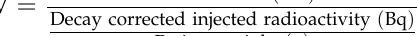
(cid:3145)(cid:3163)(cid:3159)(cid:3177)(cid:3179)(cid:3176)(cid:3163)(cid:3162) (cid:3176)(cid:3159)(cid:3162)(cid:3167)(cid:3173)(cid:3159)(cid:3161)(cid:3178)(cid:3167)(cid:3180)(cid:3167)(cid:3178)(cid:3183) (cid:4666)(cid:3134)(cid:3175)(cid:4667) (cid:3154)(cid:3173)(cid:3182)(cid:3163)(cid:3170) (cid:3180)(cid:3173)(cid:3170)(cid:3179)(cid:3171)(cid:3163) (cid:4666)(cid:3171)(cid:3144)(cid:4667) Measured radioactivity ( Bq ) (cid:3136)(cid:3163)(cid:3161)(cid:3159)(cid:3183) (cid:3161)(cid:3173)(cid:3176)(cid:3176)(cid:3163)(cid:3161)(cid:3178)(cid:3163)(cid:3162) (cid:3167)(cid:3172)(cid:3168)(cid:3163)(cid:3161)(cid:3178)(cid:3163)(cid:3162) (cid:3176)(cid:3159)(cid:3162)(cid:3167)(cid:3173)(cid:3159)(cid:3161)(cid:3178)(cid:3167)(cid:3180)(cid:3167)(cid:3178)(cid:3183) (cid:4666)(cid:3134)(cid:3175)(cid:4667) Voxel volume ( mL ) (cid:3148)(cid:3159)(cid:3178)(cid:3167)(cid:3163)(cid:3172)(cid:3178) (cid:3181)(cid:3163)(cid:3167)(cid:3165)(cid:3166)(cid:3178) (cid:4666)(cid:3165)(cid:4667) Decay corrected injected radioactivity ( Bq ) Patient weight ( g